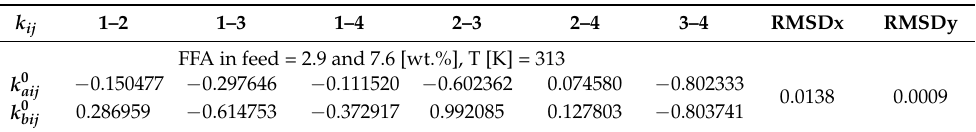
Table 16. Estimated RK-Aspen-EOS binary interaction parameters for multicomponent system FFA (oleic acid)(l)-Triglyceride (triolein)(2)-Squalene(3)-CO 2